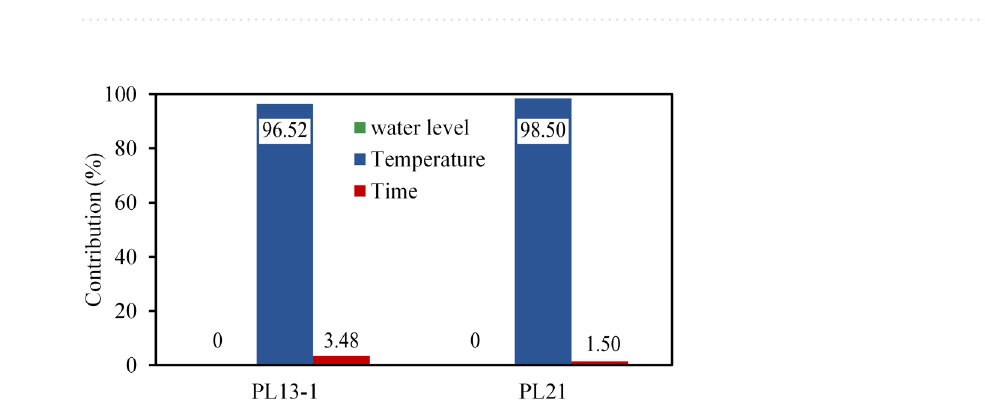
Figure 17. Influence of water level variation on radial displacement.